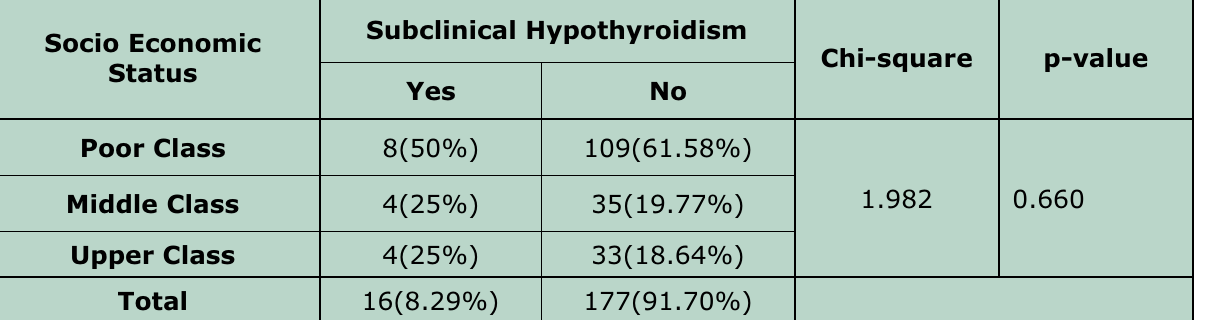
Table-II: Stratification of socio economic status